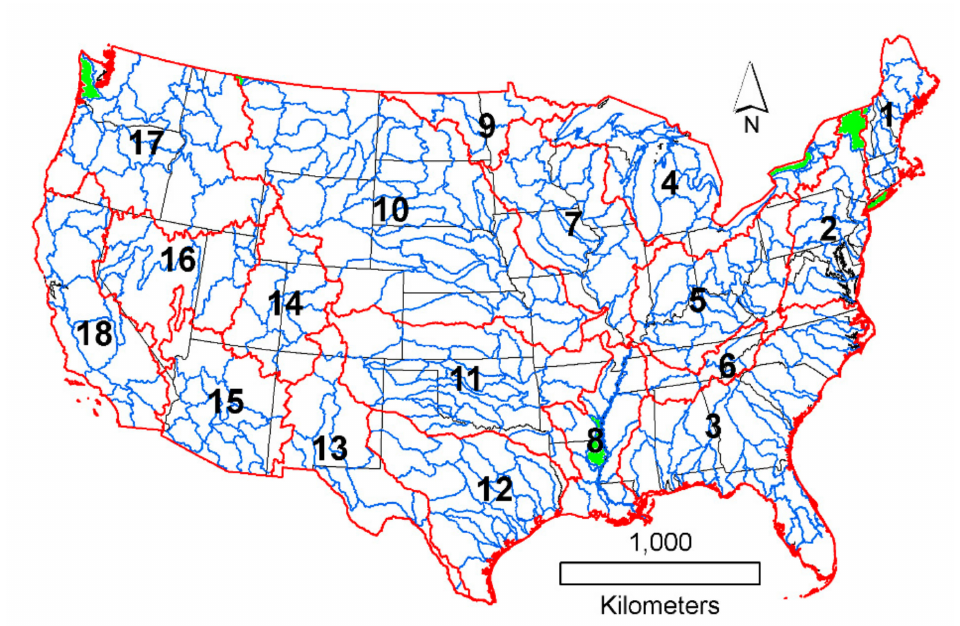
Figure 1. Distribution of the (a) 18 HUC2 (in red), and; (b) 334 HUC6 (in blue) basins across the conterminous United States. The green-colored HUC6 basins yielded outlying stream discharge values and were left out of the quantitative analysis. The names of the 18 HUC2 basins